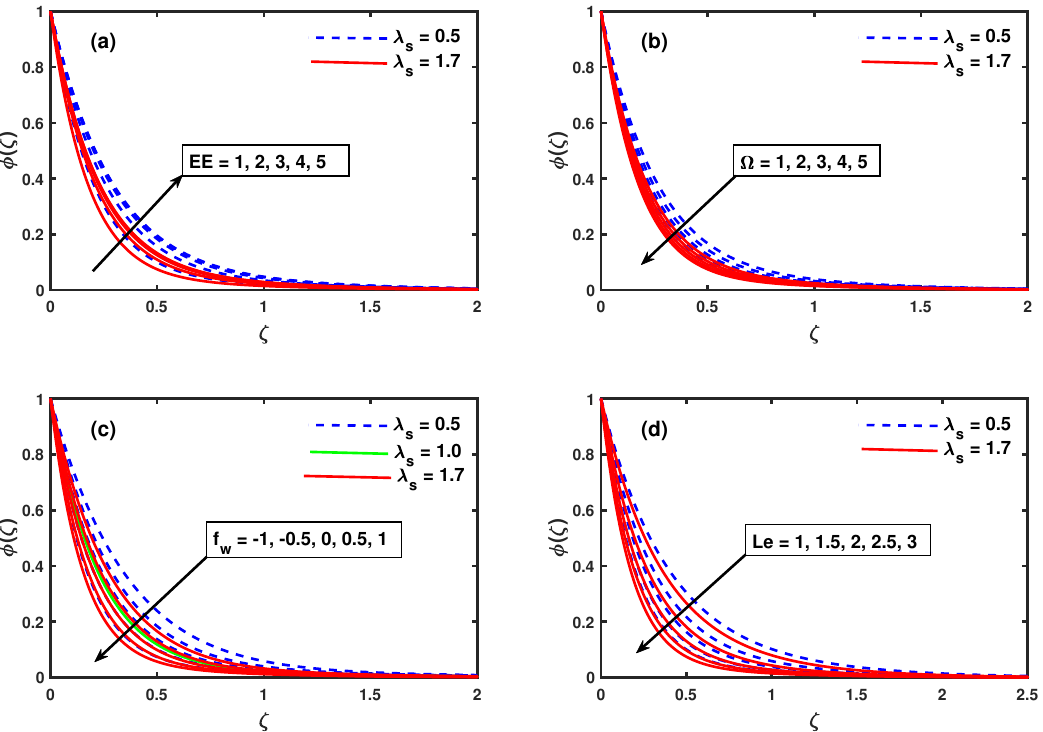
Figure 5. Fluctuation of nanoparticle concentration profile ( φ ( ζ ) ) along with activation energy ( EE ) ( a ), chemical reaction rate ( Ω ) ( b ), suction/injection ( f w ) ( c ), and Lewis number ( Le ) ( d